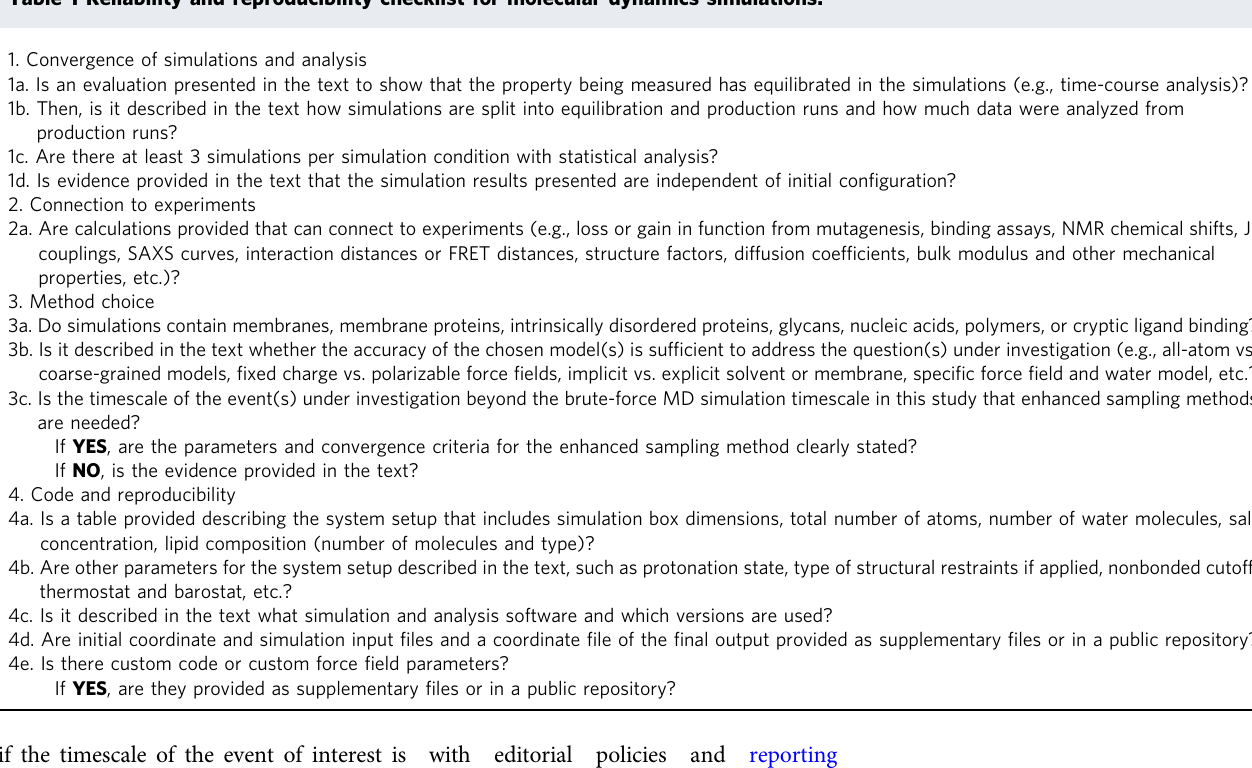
Table 1 Reliability and reproducibility checklist for molecular dynamics